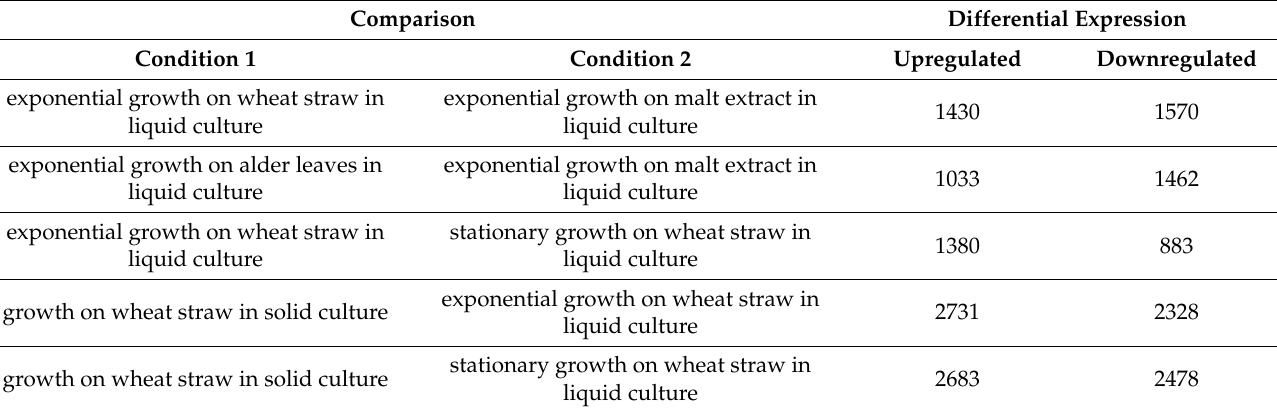
Table 2. Number of up- and down-regulated genes for different comparisons.